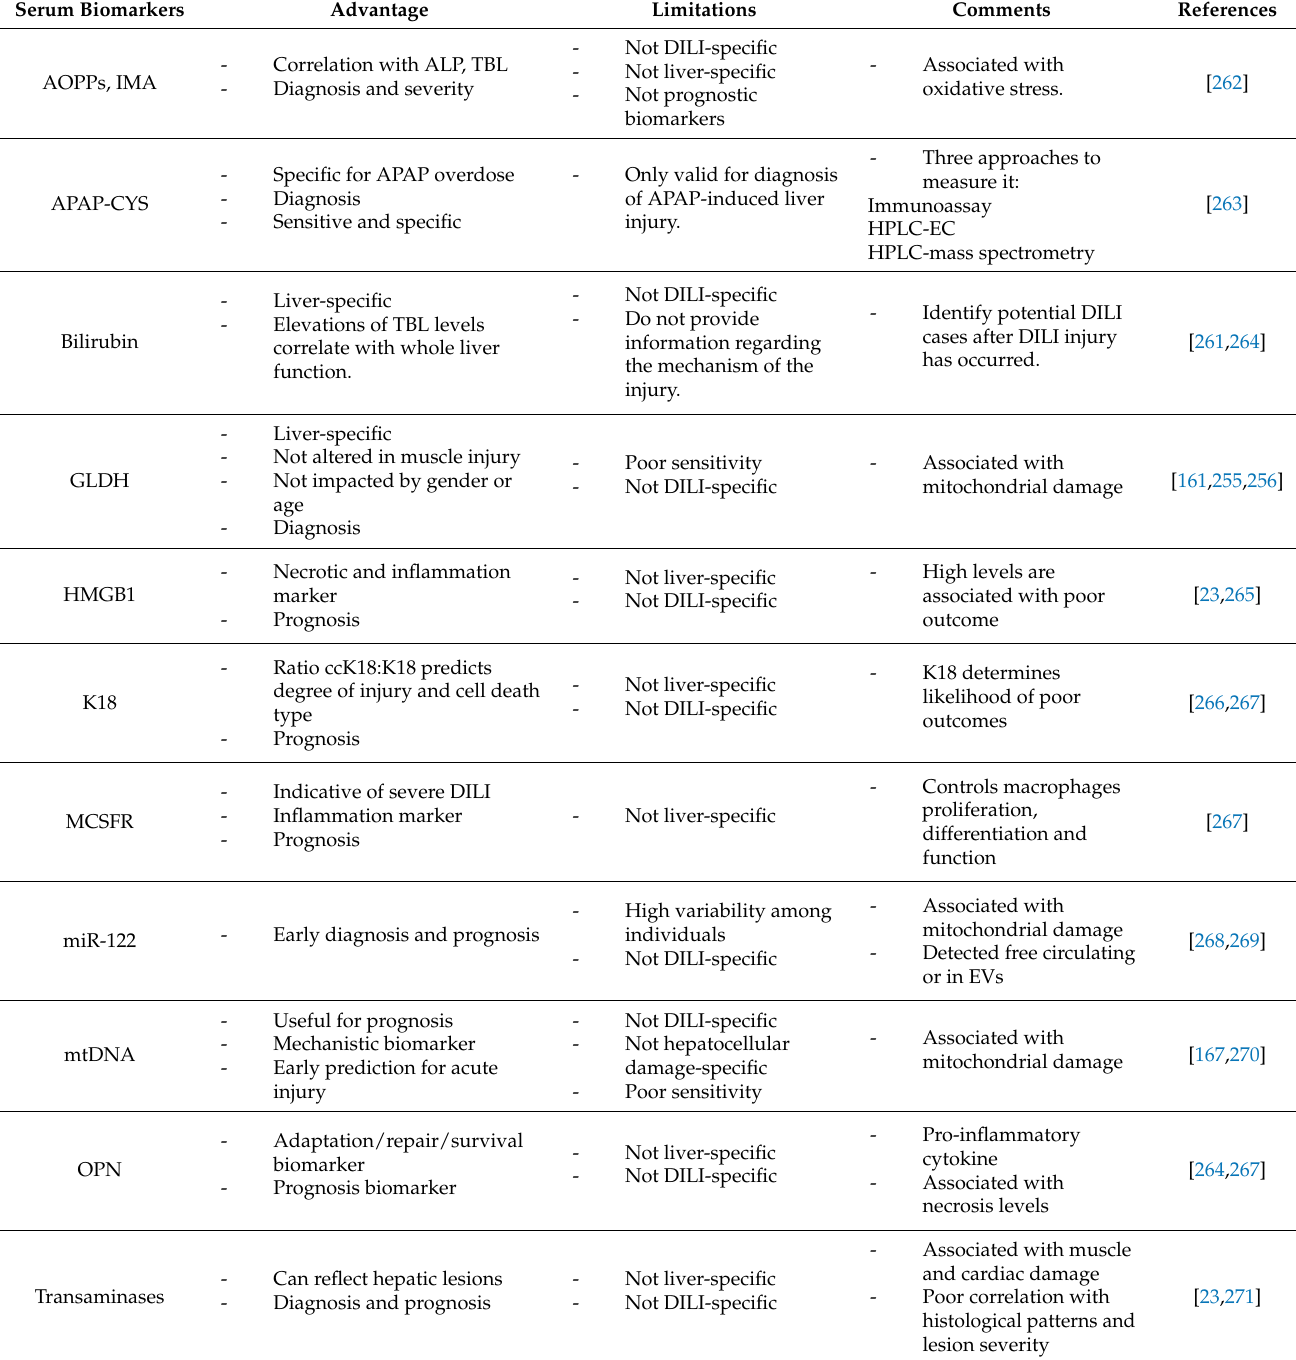
Table 4. Serum biomarkers associated with